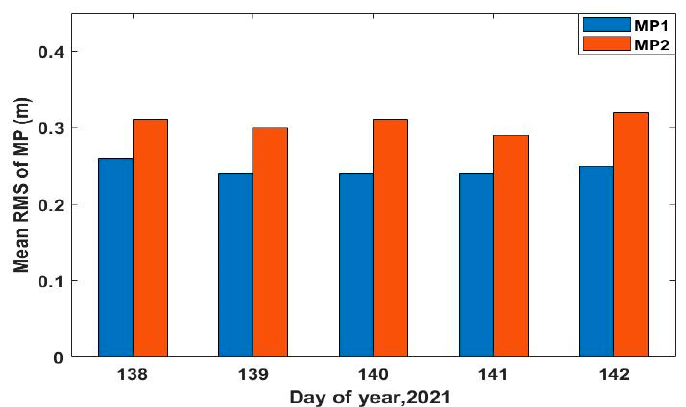
Figure 6. Mean multipath errors of six COSMIC-2 satellites during DOY 138–142, 2021.